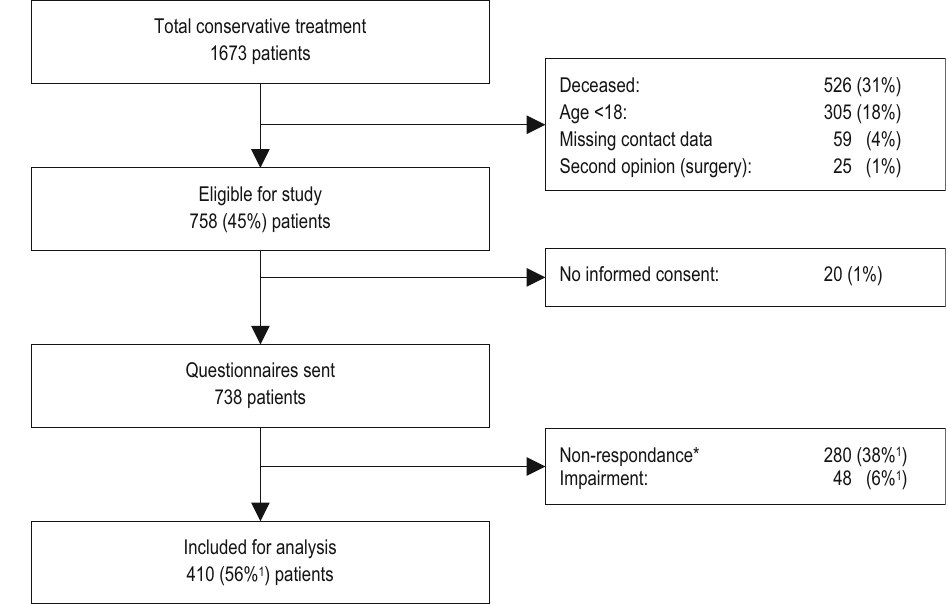
Fig. 1 Study population flow